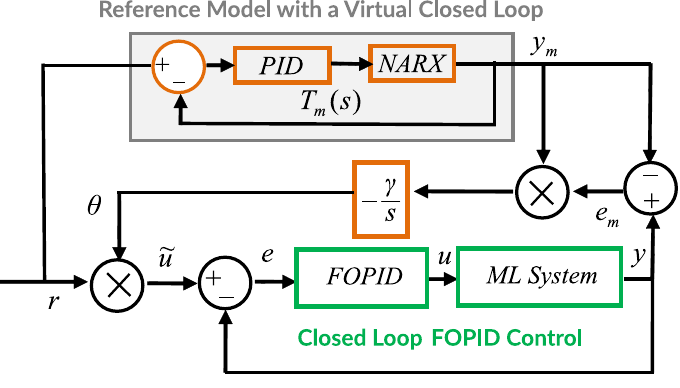
Figure 10. Block diagram of multi-loop MRAC-FOPID control with a NARX reference